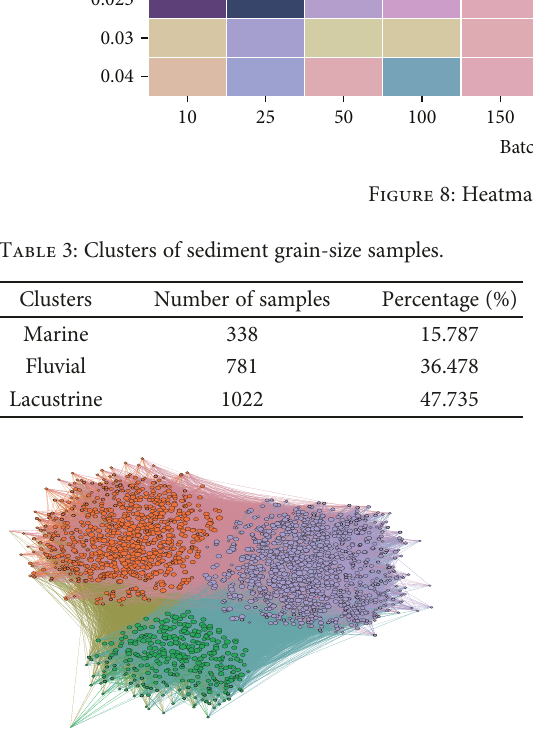
Figure 9: The clusters in the Sample network